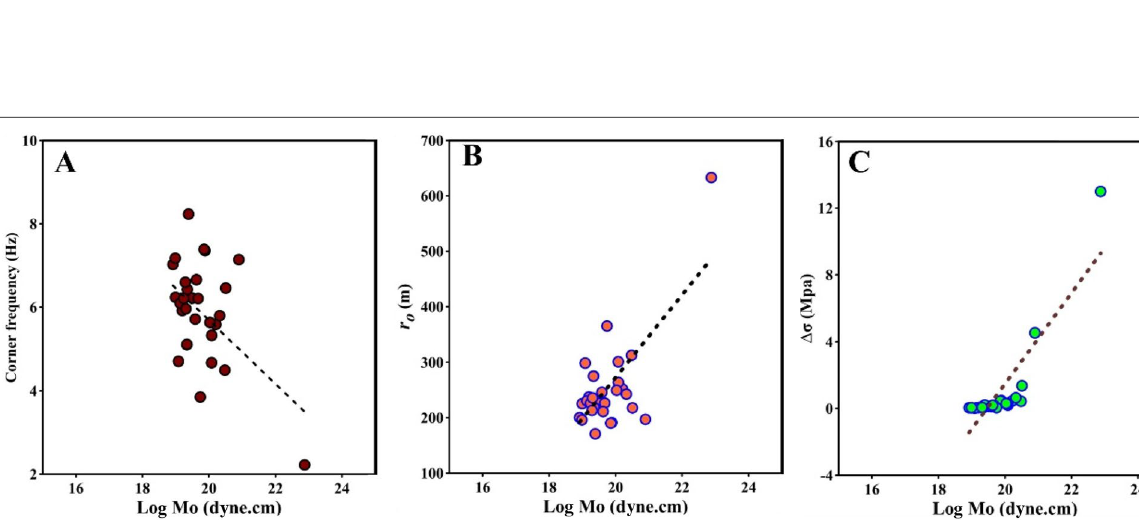
Fig. 10 The dependence of the seismic moment in logarithmic scale on the essential spectral parameters including (corner frequency, source radius, and stress